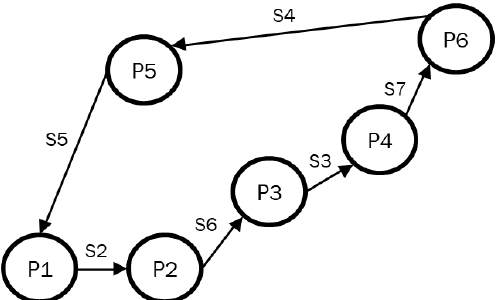
Figure 8. Graph diagram of the adjacency ordering for